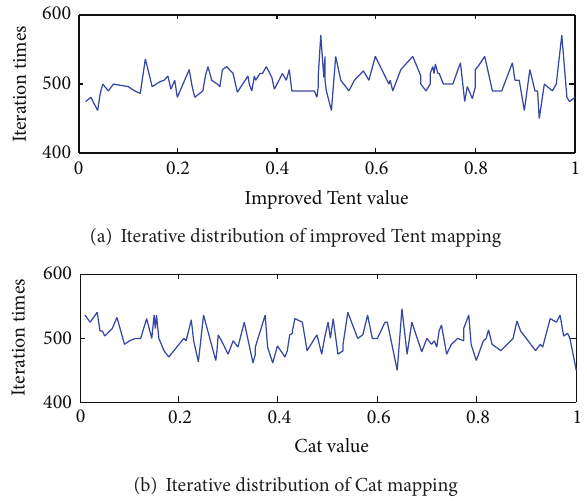
Figure 3: Two kinds of iterative distribution of mapping.